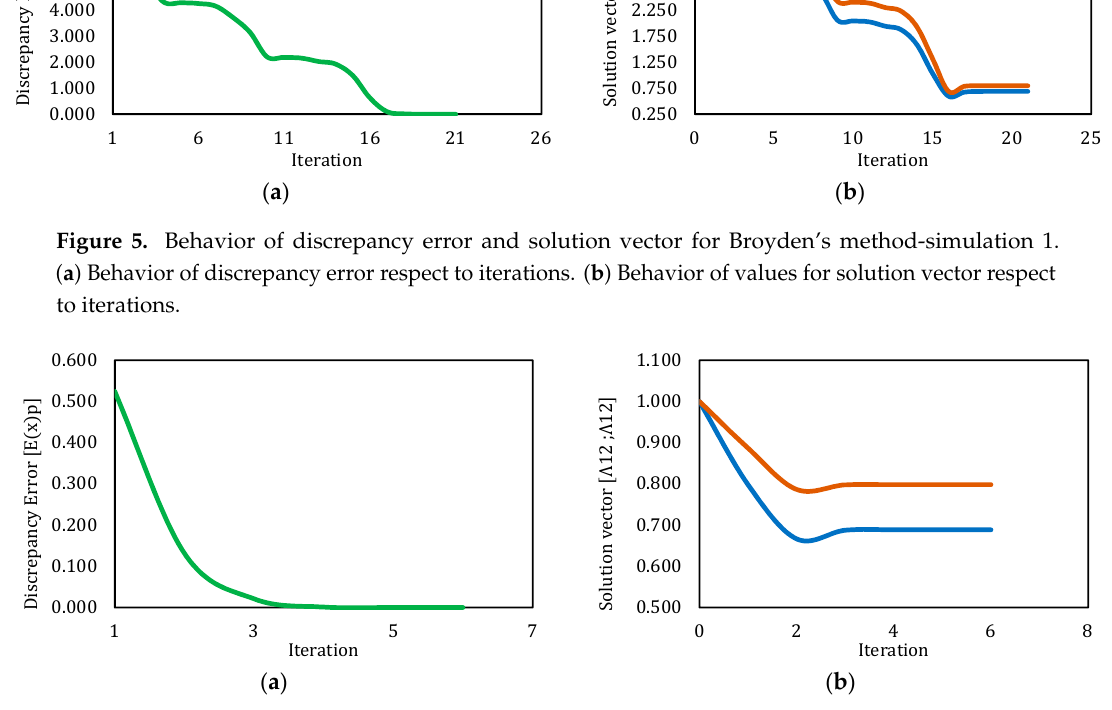
Figure 6. Behavior of discrepancy error and solution vector for Broyden’s method-simulation 2. ( a ) Behavior of discrepancy error respect to iterations. ( b ) Behavior of values for solution vector respect to iterations.